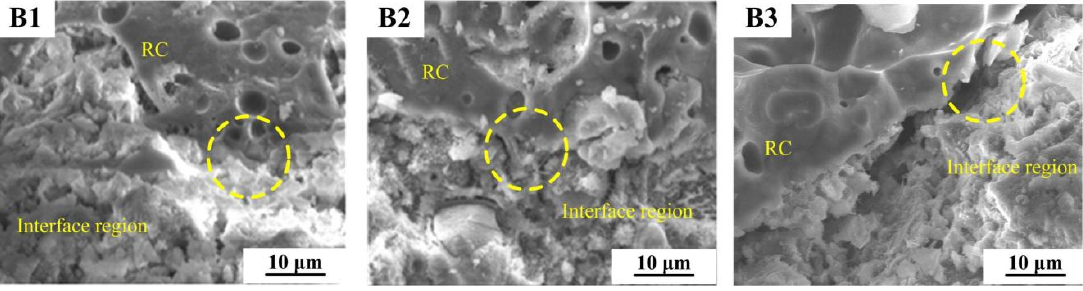
Figure 9. The low magnification SEM images of arched shell interface transition zone in specimens B1–B3 after 28 days curing time.